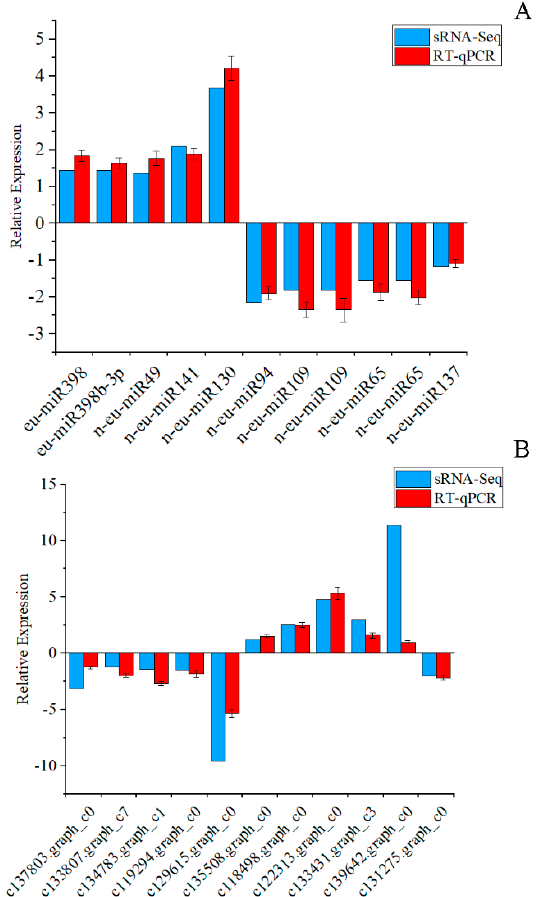
Figure 8. Validation of the expression of miRNAs ( A ) and their targets ( B ) through real-time quantitative PCR (RT-qPCR). The y-axis shows the relative expression (log 2 (fold-change)). Bars represent the standard deviation of the three biological replicates.